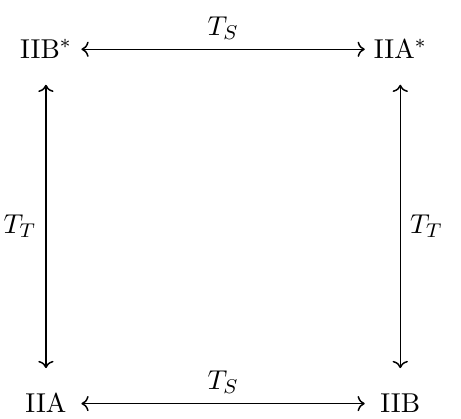
Figure 1 . Diagram showing the relationship between II and II ∗ theories, where T S ( T T ) denotes a spacelike (timelike)